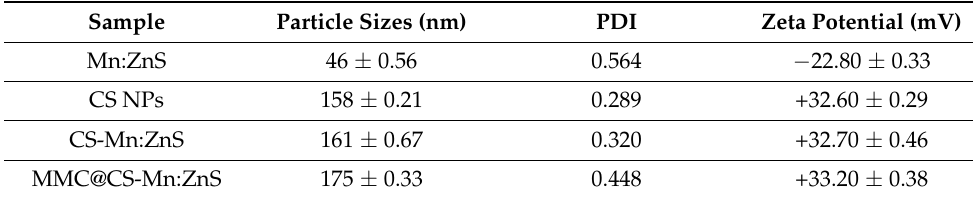
Table 3. Evaluation of particle sizes, PDI and zeta potential for